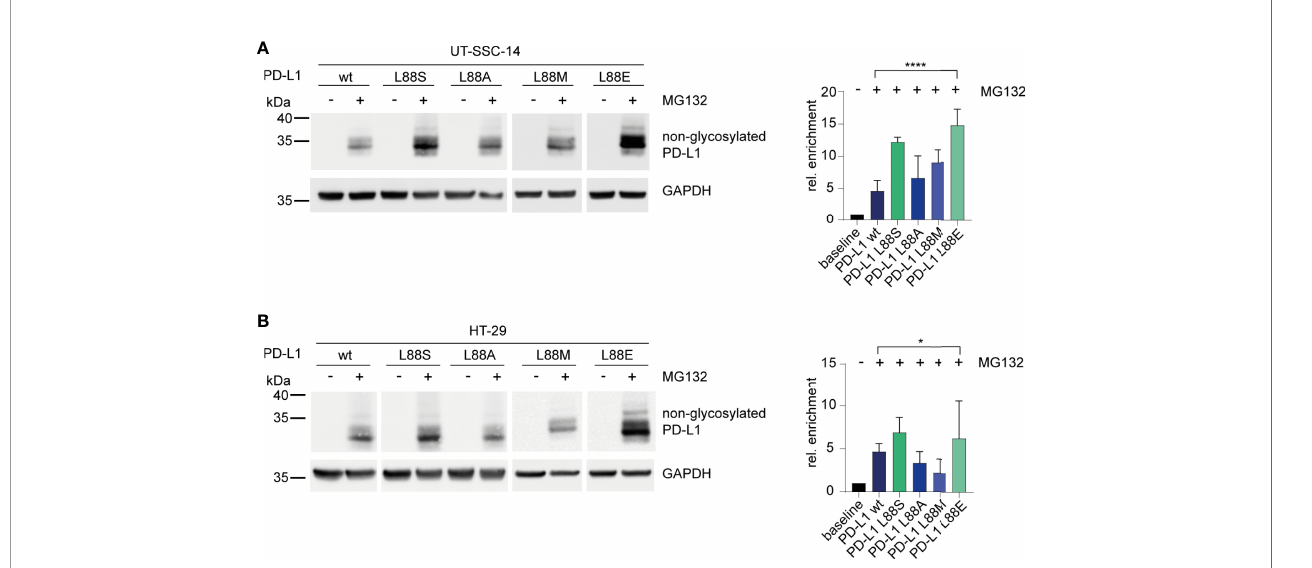
FIGURE 4 | Inhibition of the 26S proteasome and examination of its effect on different PD-L1 variants. (A) UT-SCC-14 or (B) HT-29 cells overexpressing fi ve different PD-L1 variants were treated with MG132 to block the 26S proteasome, and cell lysates were analyzed by Western blotting before and after treatment. Band intensities of non-glycosylated PD-L1 derived from at least three independent experiments were quanti fi ed using ImageJ, and enrichment of PD-L1 was calculated relative to untreated samples (=baseline) after normalization to GAPDH concentrations (24). Data are presented as mean ± SD. Statistics: one-way ANOVA over all groups. Asterisks indicate p -value range (* p < 0.05; ** p < 0.01; *** p < 0.001; **** p < 0.0001; ns >